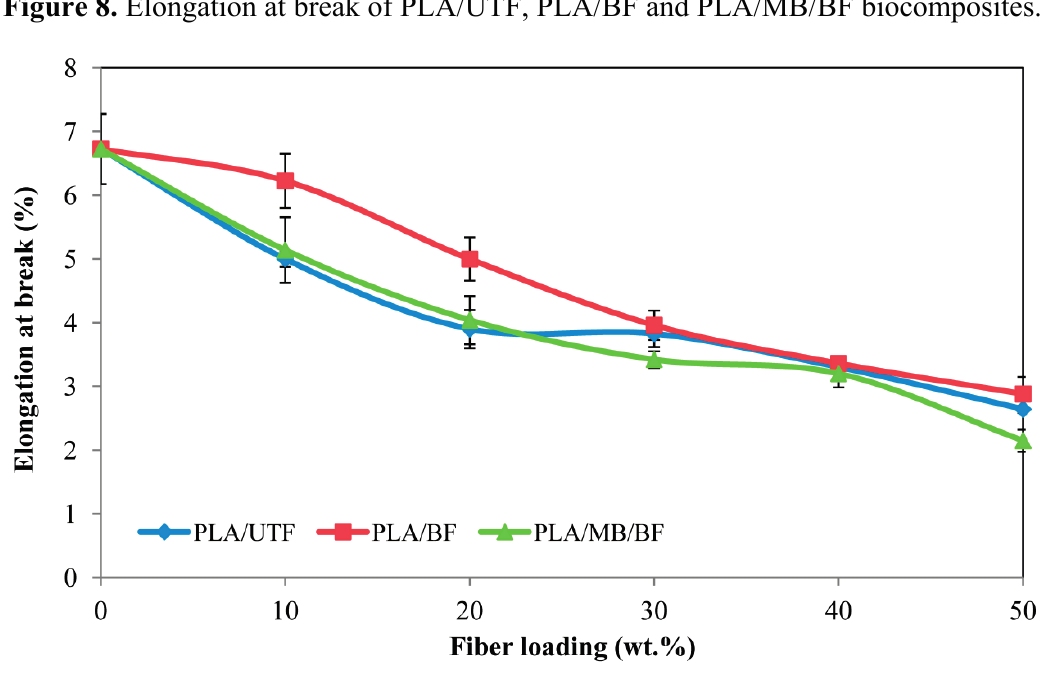
Figure 8. Elongation at break of PLA/UTF, PLA/BF and PLA/MB/BF biocomposites.